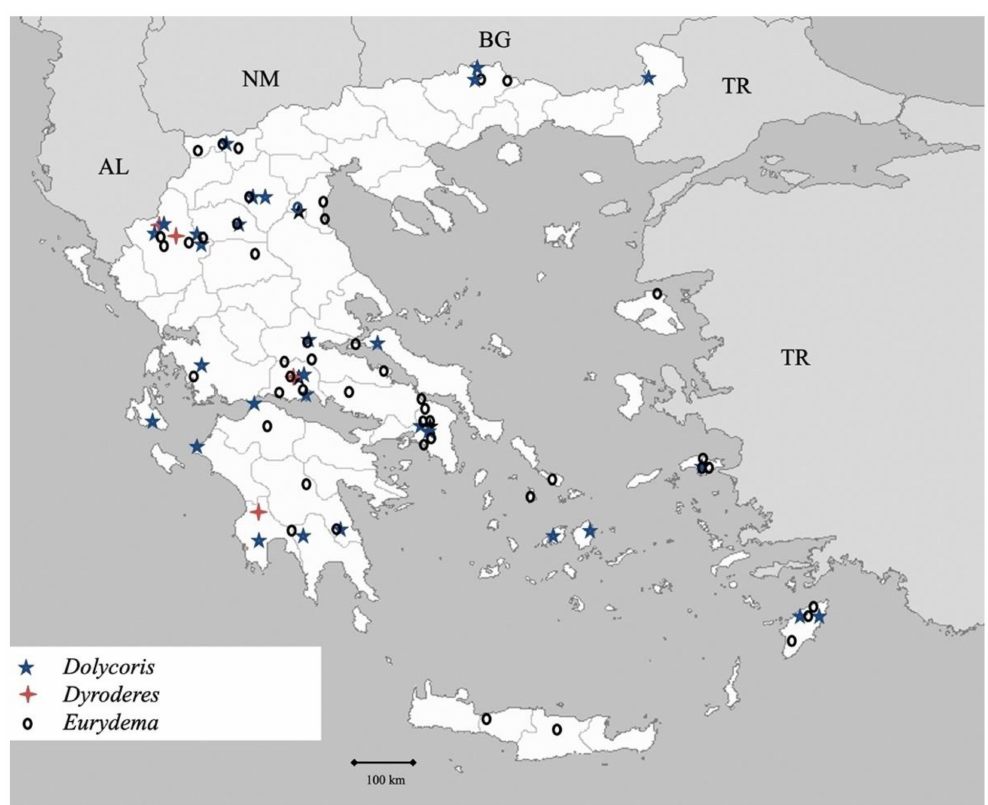
Figure 8. Map showing collecting sites of species of genera Dolycoris, Dyroderes and Eurydema during the present study in